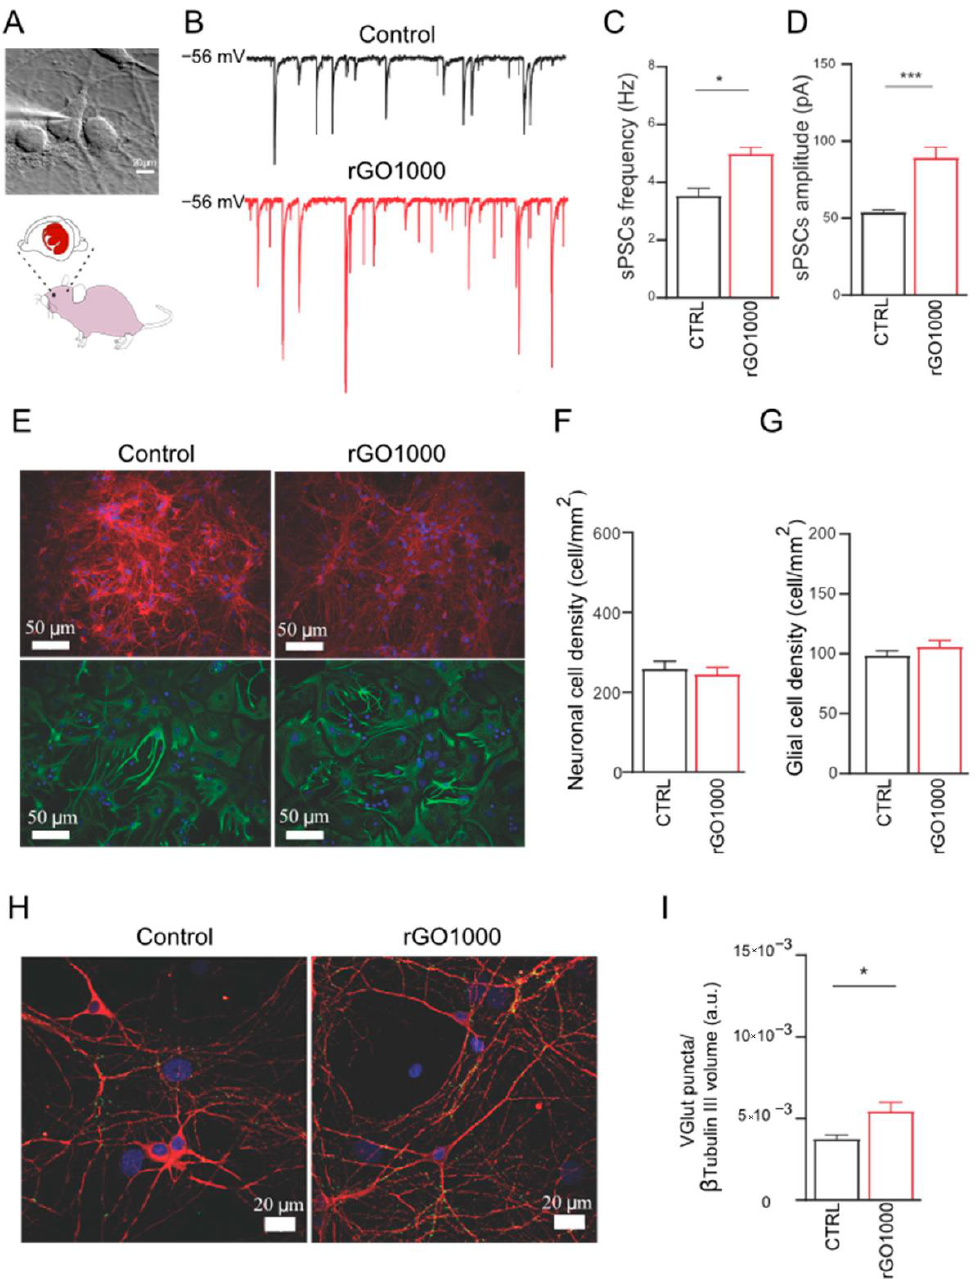
Figure 2. Impact of GO derivatives on the nervous system. ( A ) Neuronal cultures were obtained from rat brain after exposure to GO derivate (rGO1000) or vehicle (control). ( B ) Neuronal activity was monitored by patch-clamp (exemplificative voltage-clamp traces). ( C ) rGO1000 treated neurons presented a significant increase in spontaneous postsynaptic currents (sPSCs) frequency, and ( D ) amplitude. ( E ) Immunofluorescence images representative of neurons ( β -tubulin III in red), glial cells (GFAP in green), and nuclei (DAPI in blue). ( F ) Neuronal and ( G ) glial densities in control and treated condition. ( H ) Confocal reconstructions of control and treated neurons stained for the vesicular glutamate transporter 1 (VGLUT1 in green) and for β -tubulin III (red); nuclei are stained with DAPI (in blue). ( I ) VGLUT1-positive puncta (synaptic activity) in rGO1000 treated cultures increased significantly. Reproduced with permission [54]. * p = 0.1; *** p = 0.005. CNTs were investigated on nerve conduits and axon regeneration [60 – 62]. Single and multi-layer CNTs, as GO, exhibit good conductivity and biocompatibility [63]. At the neu- ral cell interface, they can potentiate synaptic networks' formation and function [64]. Thus,